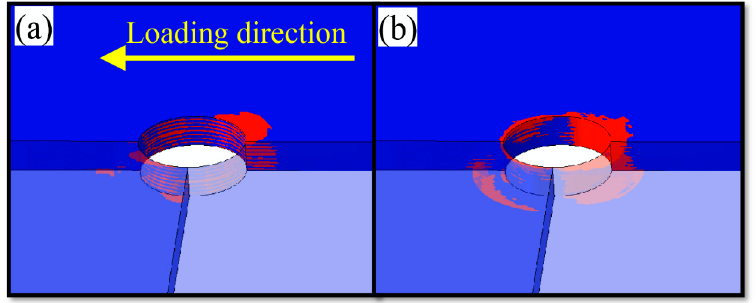
Figure 11. FEM results of hole circumference at B (( a ) fiber kinking, ( b ) matrix damage).